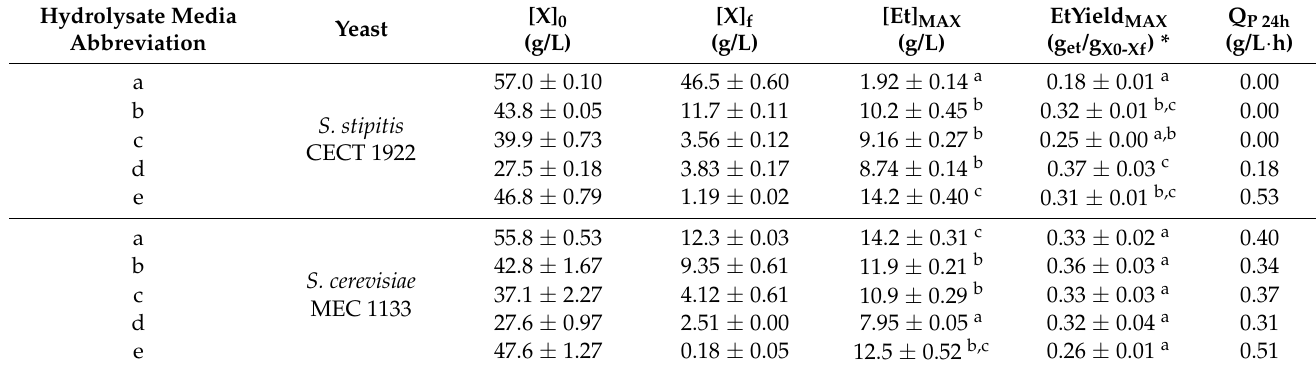
Table 2. Fermentation results for the different options of hemicellulosic hydrolysate media, namely non-detoxified hy- drolysate at percentages of 100% (a), 80% (b), 60% (c), and 50% (d), and detoxified hydrolysate at 100% (e). Data show the initial and final concentrations of xylose ([X] 0 , [X] f ), maximum ethanol concentration and yield ((Et) MAX , EtYield MAX ) and volumetric productivity at 24 h (Q P24h ), along with standard deviations. Different letters indicate significant differences ( p < 0.02) for (Et) MAX and EtYield MAX for each strain.